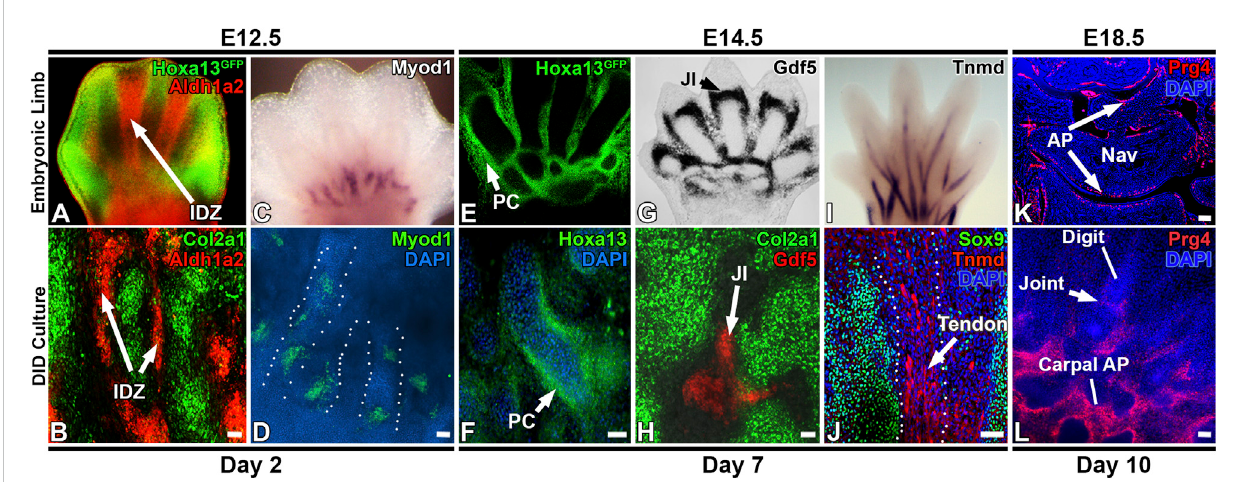
FIGURE 6 Recapitulation of digit/carpal element gene expression patterns by the DID system. (A,B) Day 2 cultures recapitulate digit and interdigital tissue development as detected by Col2a1 expression in the presumptive digit condensations and Aldh1a2 in the interdigital zones (arrows, IDZ). (C,D) Myod1 expression patternatthedigitbaseisrecapitulated inDay2cultures.Dashedlinesdepict individual digitsforming intheDayDIDcultureinpanel (D) . (E,F) Day 7 cultures recapitulate Hoxa13 expression patterns that localize to the periphery of digit condensations. (G) Developmental expression of Gdf5 in the E14.5 forelimb joint interzone (JI, arrowhead). (H) Day 7 DID cultures recapitulate Gdf5 expression localizing to presumptive joint interzones between digit structures (JI, arrow). (I) Maturing tendons robustly express Tnmd in E14.5 autopods. (J) IHC analysis of Sox9 and Tnmd expression in Day 10DIDculturesreveals robust Tnmd expressioninmaturingtendons(arrow)formingbetweenthe Sox9 -expressing digitstructures. (K) Prg4 isexpressed in the articular perichondrium (AP, arrows) in E18.5 carpal skeletal elements. Nav = navicular element. Rad = radius. (L) Day 10 cultures recapitulate the formation of digit, joint, and carpal-like skeletal elements that express Prg4 in the articular perichondrium (AP) Bars = 50